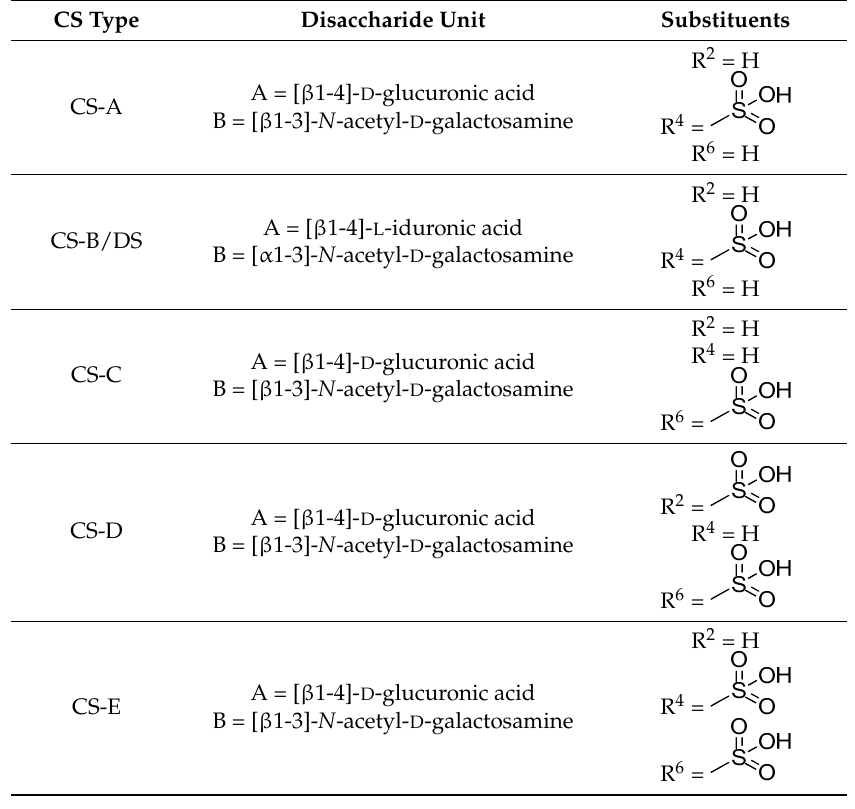
Figure 1. Disaccharide units of Chondroitin Sulphate (CS). Table 1. Common sulphation patterns of Chondroitin Sulphate (CS) disaccharides. DS, Dermatan Sulphate.